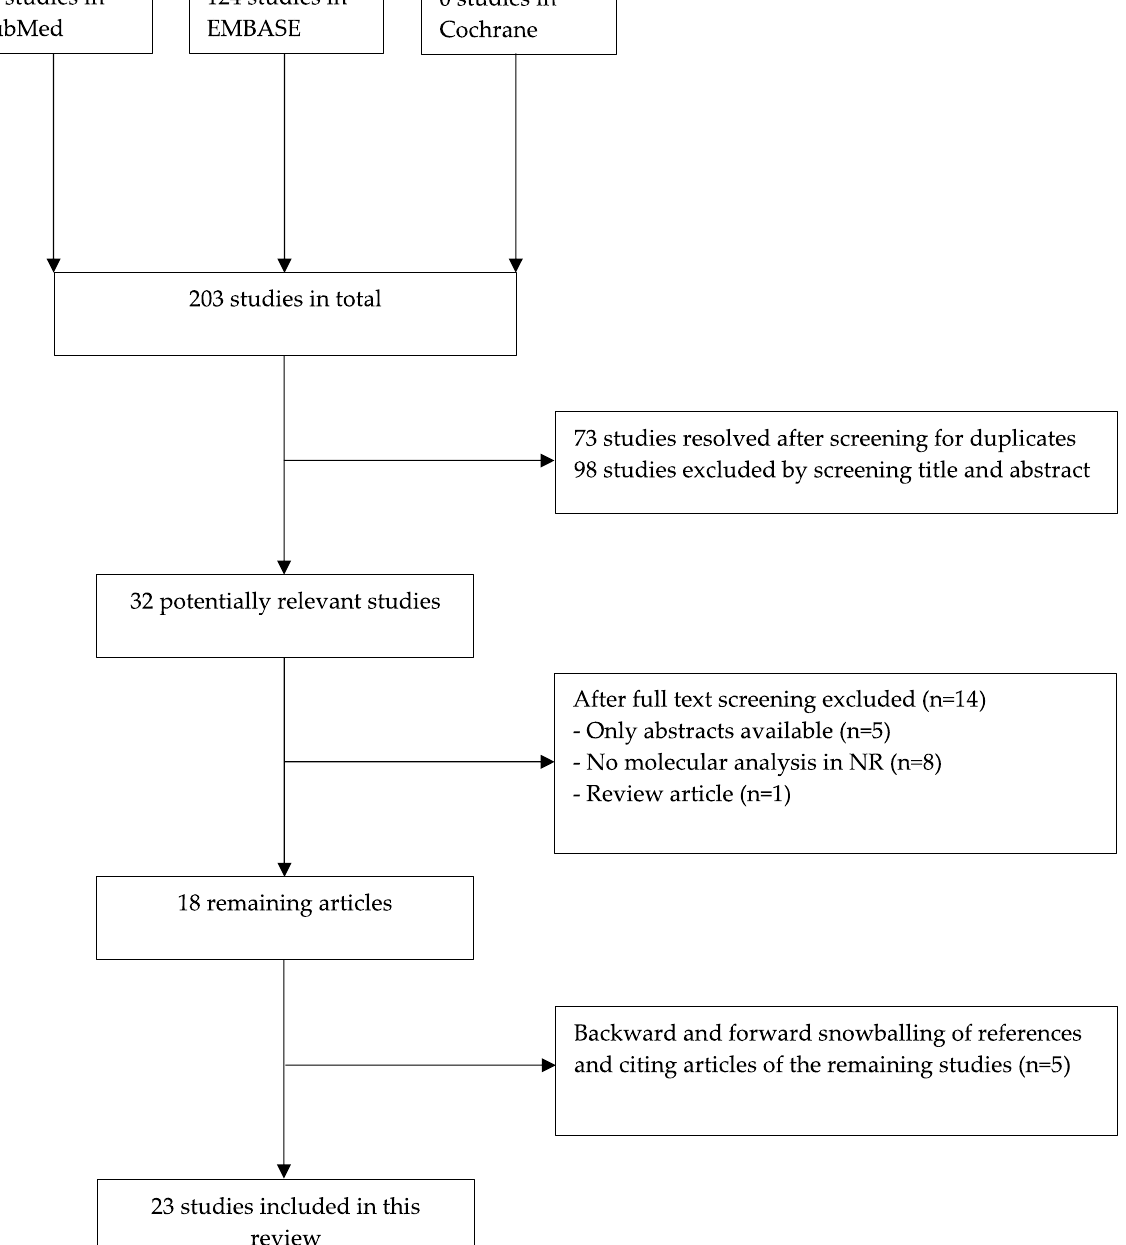
Figure 2. Flowchart of the search and selection process .